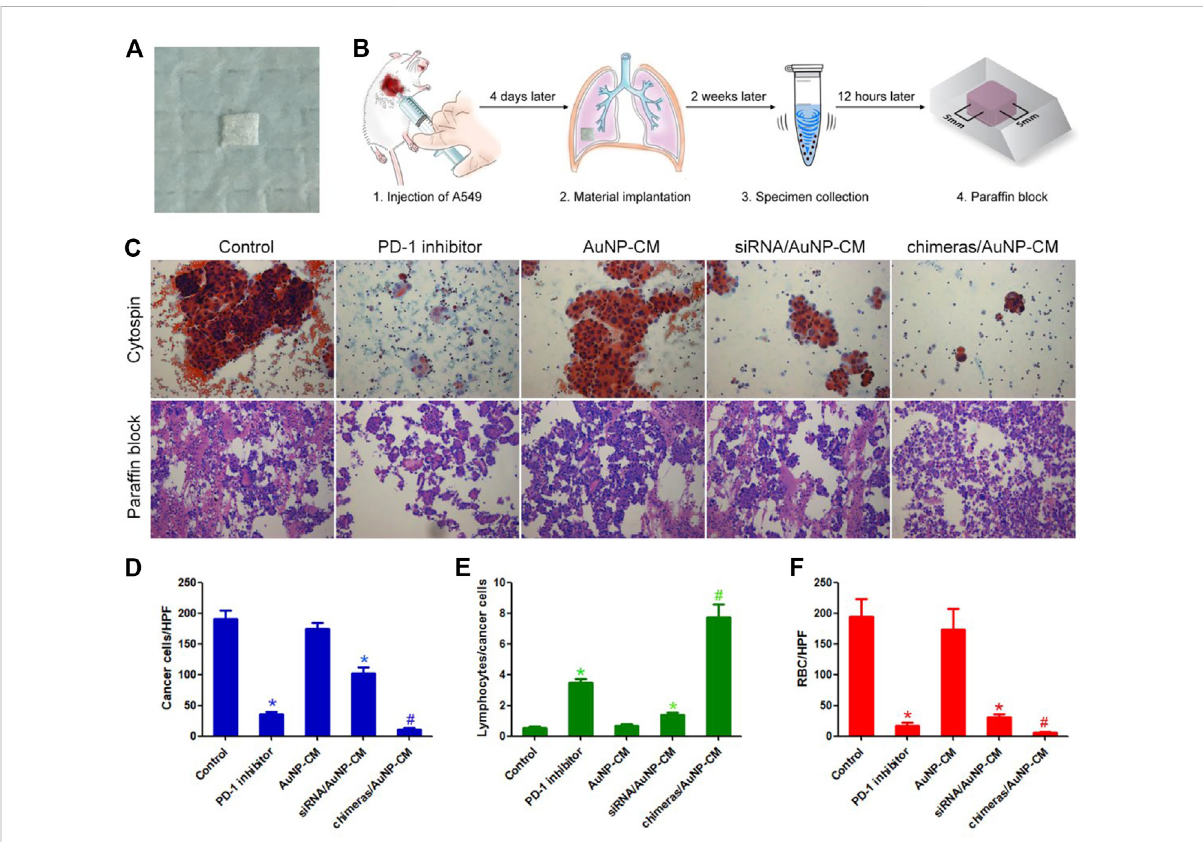
FIGURE 4 Chimeras/PEI/PEG/AuNP/collagen membrane effectively treated malignant pleural effusion in vivo (A) General picture (B) Flow chart of animal experiments (C) Cytospin andHEstainingofcellblocks (D) ComparedwiththePD-1inhibitorgroup, thenumberofcancercellsperhighpower fi eld (HPF) in pleural effusion in the chimeras/AuNP-CM group were reduced by 71.31% (E) Compared with the PD-1 inhibitor group, lymphocyte/cancer cell ratio in pleural effusion in the chimeras/AuNP group was increased by 1.20 times (F) Compared with the siRNA/AuNP-CM group, the numberofredbloodcellsperhighpower fi eld(RBC/HPF)wasmarkedlyreducedinthechimeras/AuNP-CMgroup.* p < 0.05(n=10)versusControl. # p < 0.05 (n = 10) versus siRNA/AuNP-CM. Values are mean ±